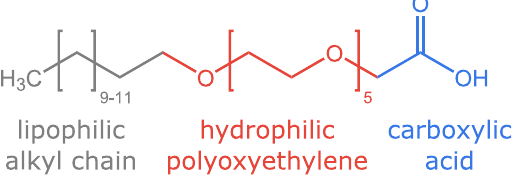
Figure 1. Chemical structure of the oligo-oxyethylene lauryl ether carboxylic acid surfactant (C 12-14 O- EO 5 CH 2 COOH) used in this